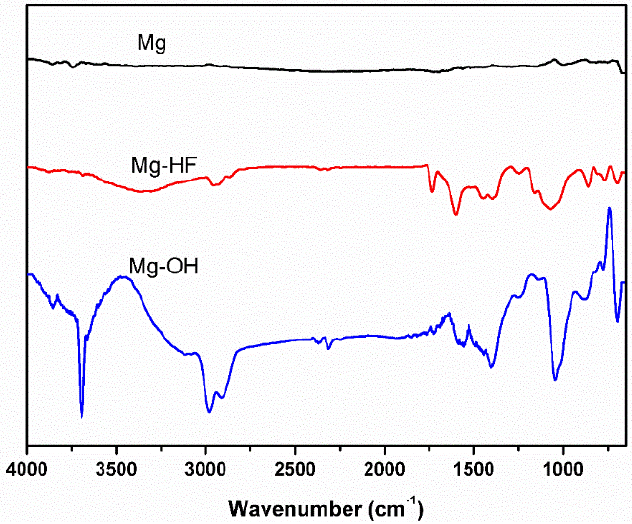
Figure 1. Attenuated total reflectance Fourier transform infrared spectroscopy (ATR-FTIR) spectra of the pristine magnesium alloy and chemical treated samples. Appl. Sci. 2017 , 7 , 9